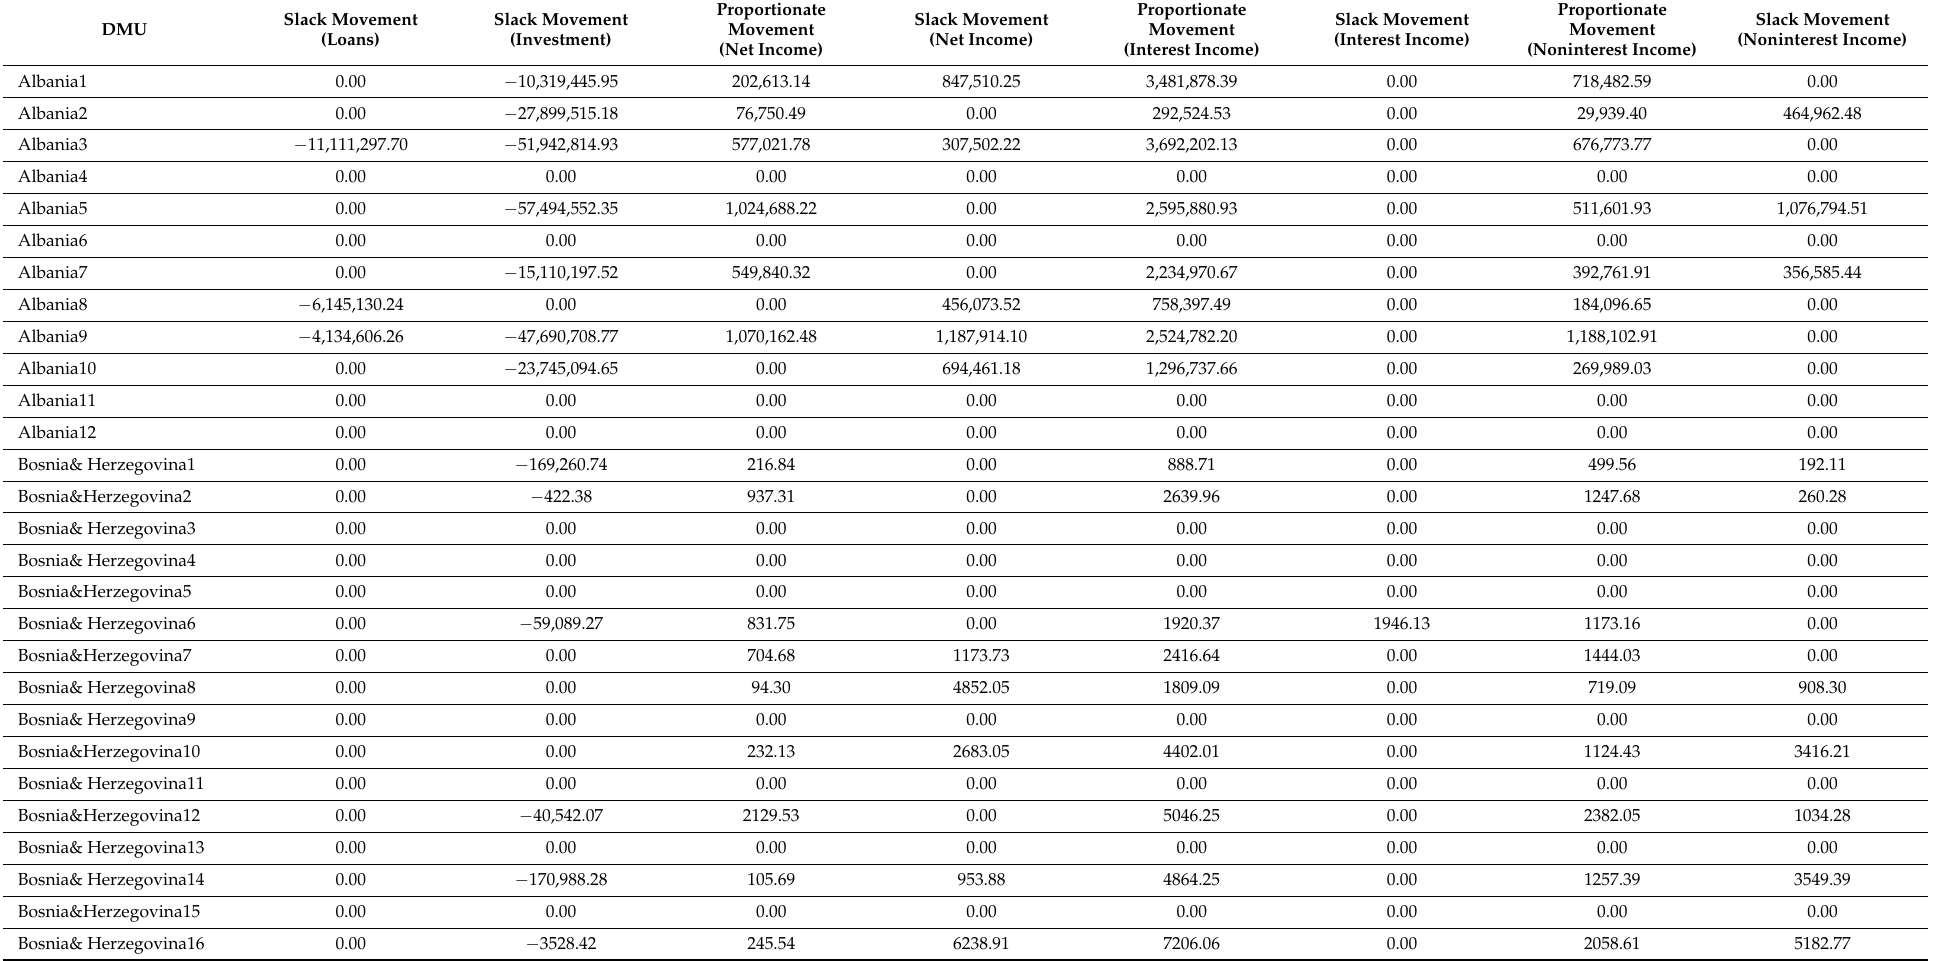
Table A2. Results of DEA model—Proportionate and Slack